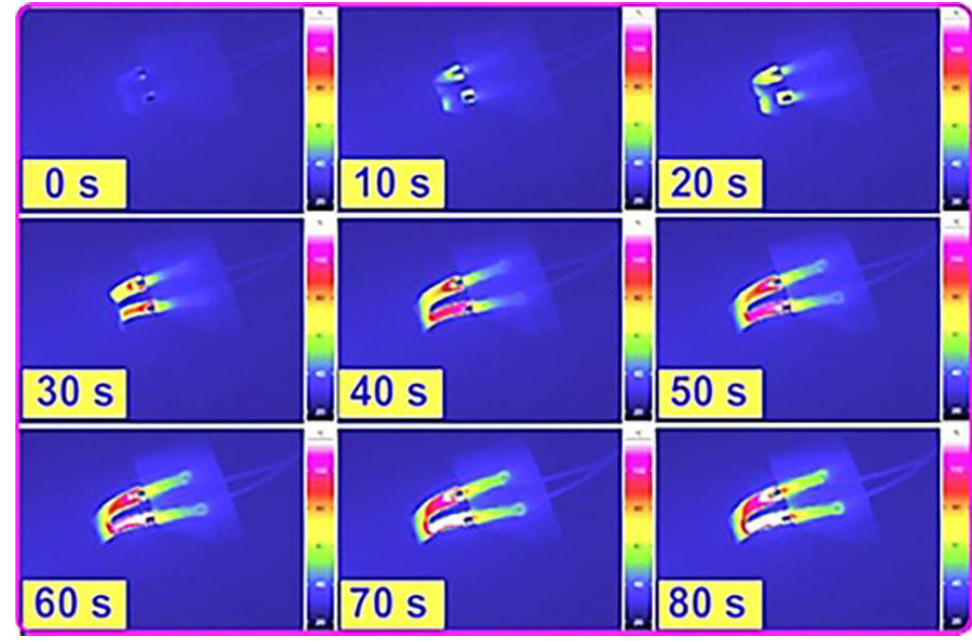
Figure 11. Snapshot of Joule heating-induced shape recovery in SMP nanocomposite recorded by infrared video camera [120]. SMP = shape memory polymer. Reproduced with permission from